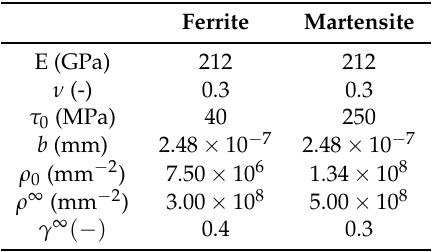
Table 3. Material parameters for ferrite and